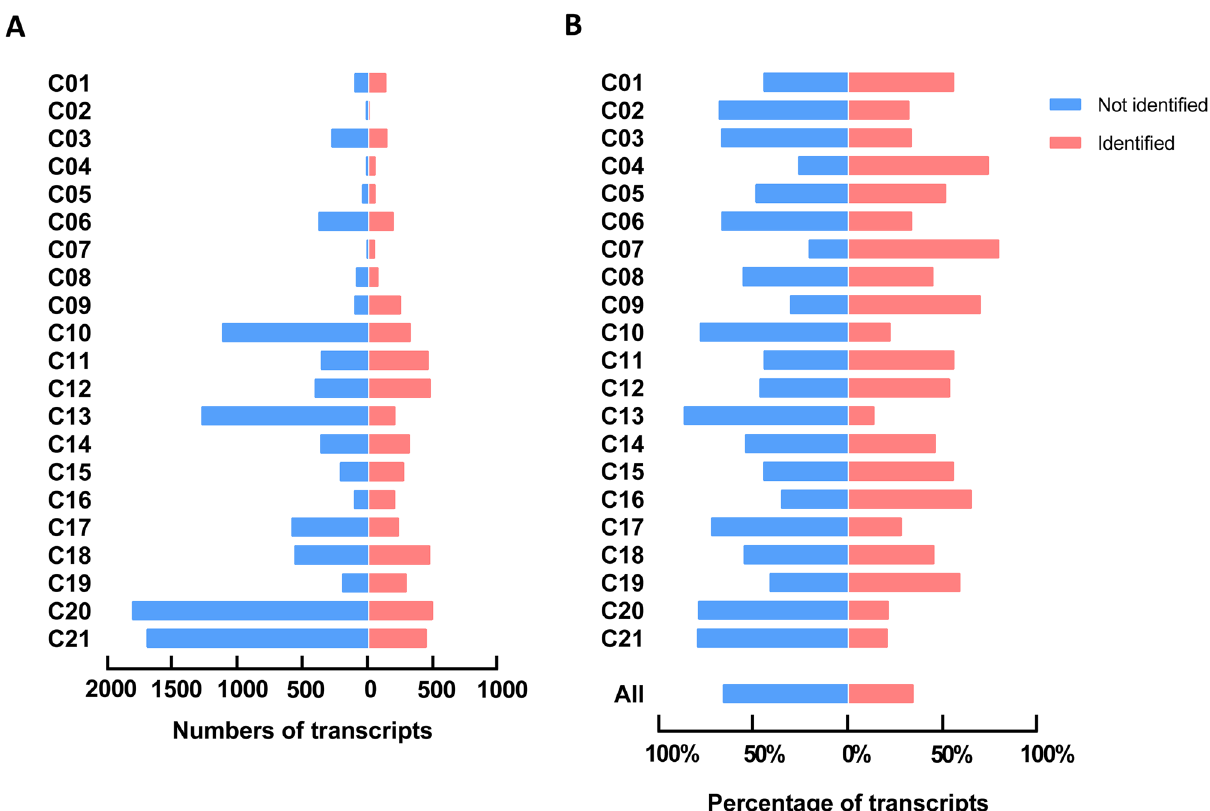
Figure 4. Transcript distribution of identified and not identified proteins in the platelet proteome per function class. Examined were all relevant protein-coding transcripts (log2fpkm ≥ 0.20) of the combined relevant PLT/ MGK transcriptome, with separation of identified proteins ( n = 5,050) and not identified proteins ( n = 9,721). For full data, see Suppl. Figure 3. ( A ) Numbers of transcripts numbers per function class. ( B ) Percentage distribution of transcripts per function